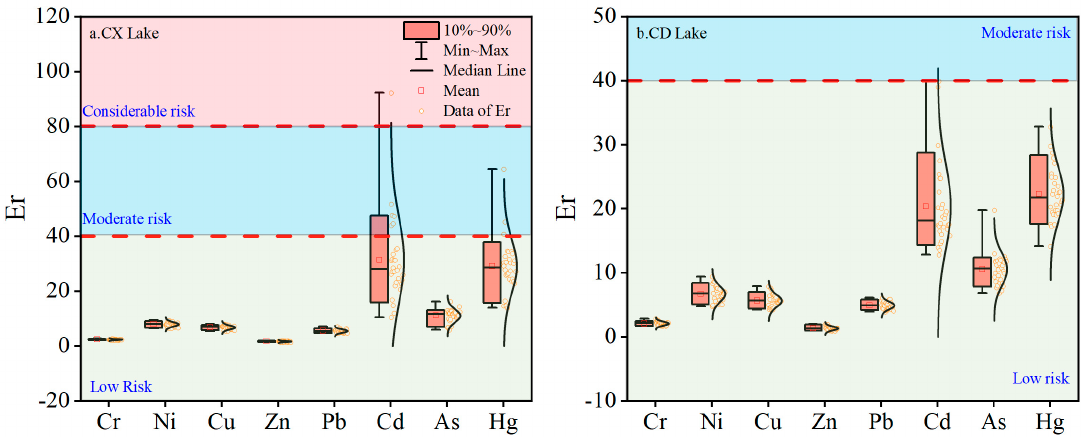
Figure 5. Boxplots of Er of sediment heavy-metal elements. ( a ) Chengxi Lake; ( b ) Chengdong Lake. 337